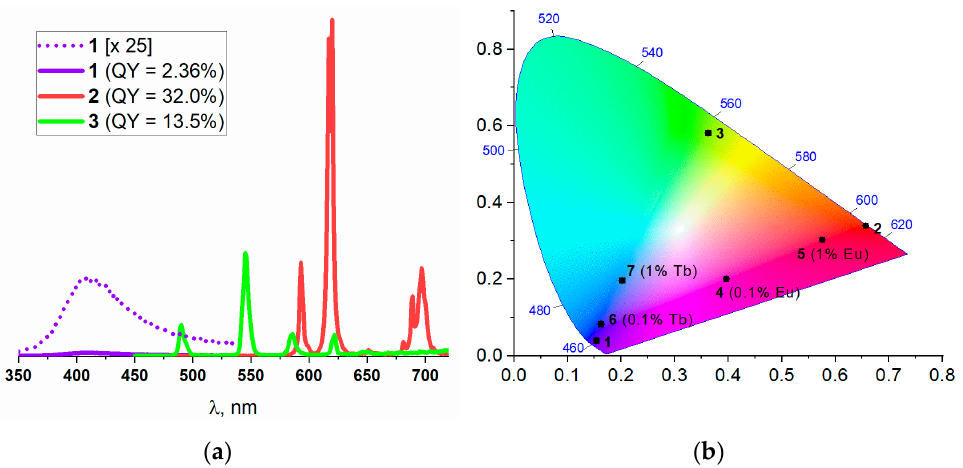
Figure 2. Emission spectra for individual compounds 1 – 3 , normalized on quantum yield ( a ). CIE 1931 chromaticity diagram for 1 – 3 and bimetallic compositions 4 – 7 at λ ex = 330 nm ( b ).